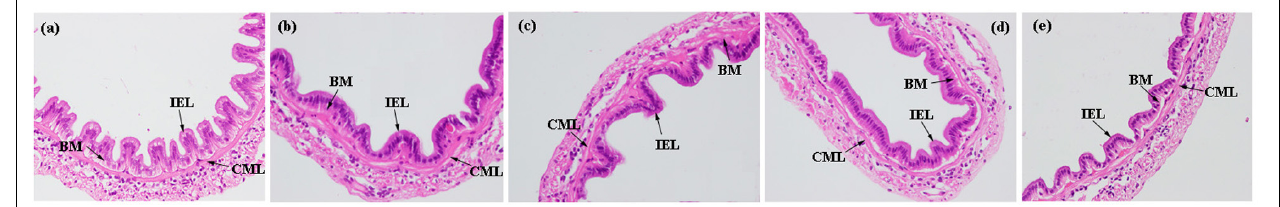
FIGURE 3 | Histological analysis of intestine from of shrimp fed diets with 0 (a) , 25% (b) , 50% (c) , 75% (d) , and 100% (e) replacement of fishmeal by fish silage (FS). BM, basement membrane; CMLs, circular muscle layers; IEL, intestinal epithelial layer. Stained with hematoxylin and eosin (H&E), 200 × .